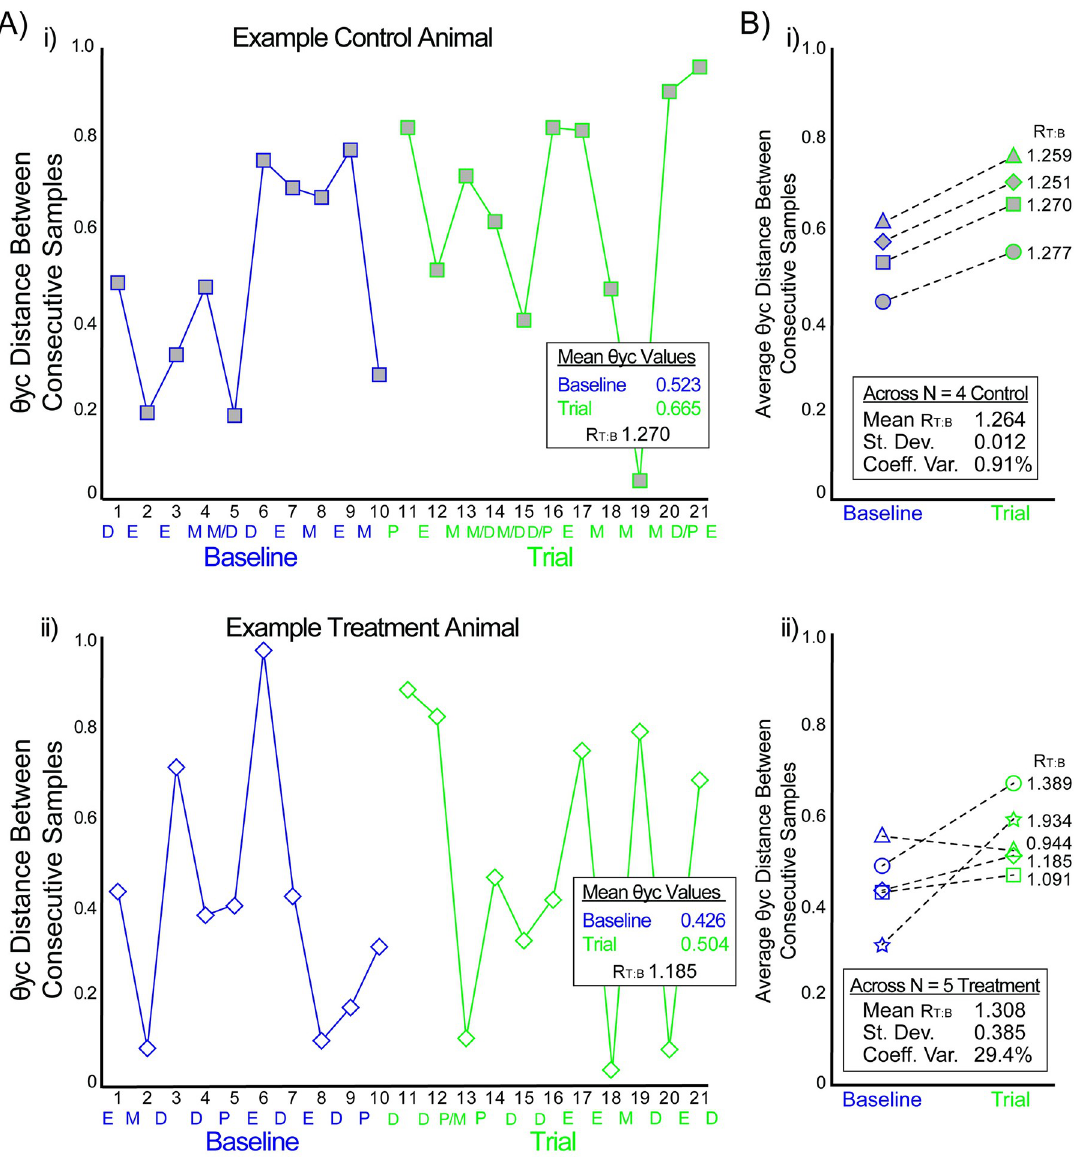
Fig 5. Θ yc distances between consecutive samples for Control and Treatment groups. A) Example scatterplots of Θ yc distances for consecutive samples for i) Control 1and ii) Treatment 2 animals. Baseline period in blue; Trial period in green. Estrous period (P/E/M/D for states) indicated at bottom of each plot. B) Mean Θ yc distances during baseline and trial periods for i) Control and ii) Treatment animals. Icons in (A) correspond to same animals in